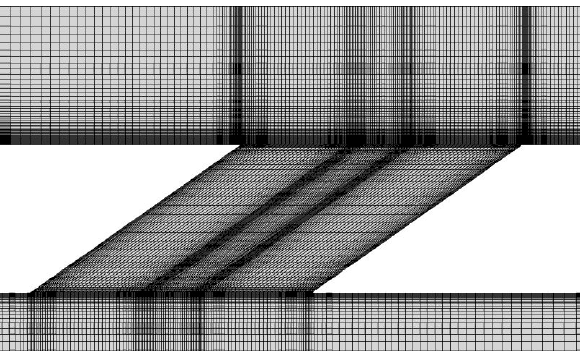
Figure 6. Close-up of the mesh near the hole.